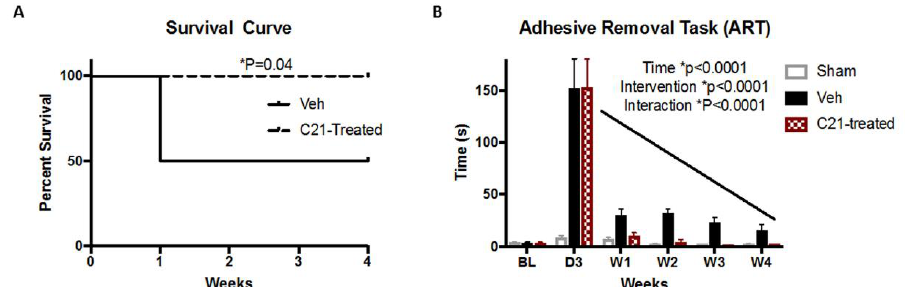
Figure 1. Delayed administration of C21 reduced mortality and improved functional deficits. ( A ) Vehicle-treated animals experienced a mortality of 50%, whereas C21-treated animals experienced no further mortality after day 3 (onset of C21 administration), log-rank test ( p = 0.04). ( B ) Sensorimotor deficits were measured using the adhesive removal task (ART). No differences were observed between vehicle- and C21-treated group mortality or sensorimotor deficits at baseline. Both vehicle- and C21-treated groups displayed similar deficits 3 days after stroke and prior to C21 administration. Day 3 C21 administration enhanced recovery after a stroke. Repeated (RM) ANOVA ( p < 0.0001 interaction), (n = 5–6/group).